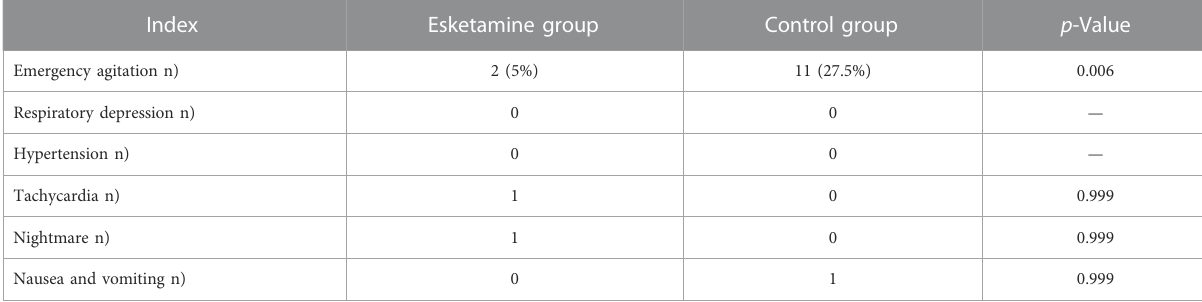
TABLE 2 Comparison of side effects in children ( n =